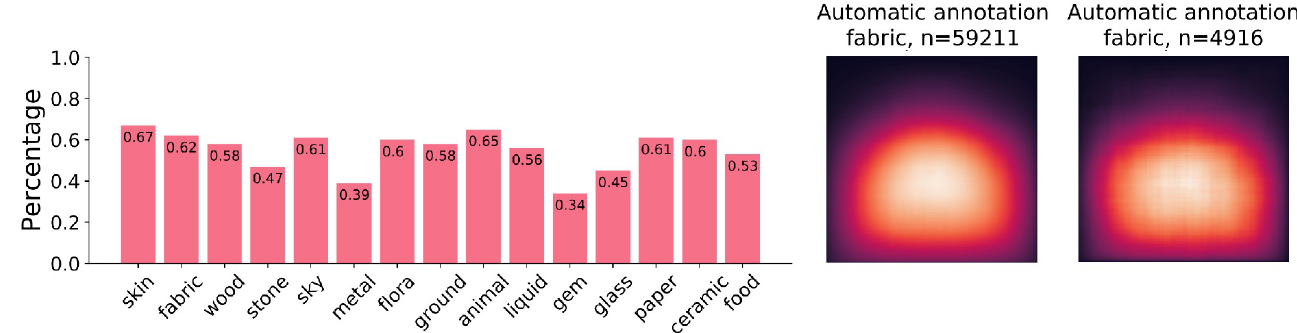
Fig 11. In the bar graph, the accuracy for automatically detected bounding boxes is displayed in the same order as in Fig 5. The values were derived from human quality votes. On the right, we compare the material heatmaps for fabric between the automated and the human annotation bounding boxes. From left to right, top to bottom: Lake George , by John William Casilear , 1857. Man with a Celestial Globe , by Nicolaes Eliasz Pickenoy , 1624. A Seven-Part Decorative Sequence: An Interior , by Dirck van Delen , 1631. Thomas Howard, 2nd Earl of Arundel , by Anthony van Dyck , 1620. The Poultry Seller , by Cornelis Jacobsz. Delff , 1631. First and second digital image courtesy of The Metropolitan Museum of Art. Third and last image courtesy of The Rijksmusuem. Fourth image courty of the Getty’s Open Content Program. All images reproduced under a CC0 license.